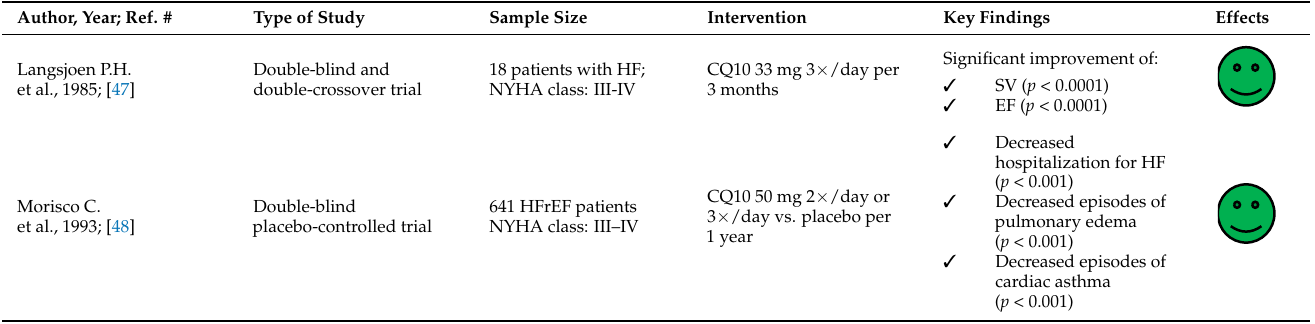
Table 2. Studies evaluating the effectiveness of CoQ10 supplementation in the treatment of HF. The only studies with multicenter, prospective, randomized, double blinded, placebo controlled, soft and hard endpoints protocols are bolded; the ones with all-cause mortality reduction positive re- sults are in red among those. Superiority (smiling, green faces) on the contrary to inferiority ones (non-smiling, orange faces) were put by the authors judging objectively the findings of coenzyme